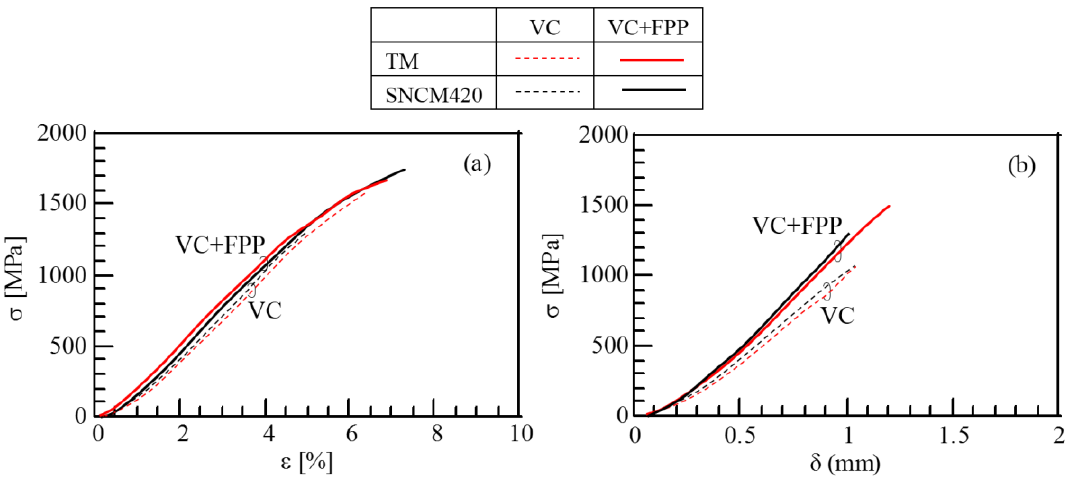
Figure 5. ( a ) Engineering stress−strain ( σ – ε ) curves of smooth specimens and ( b ) engineering stress-displacement ( σ – δ ) curves of notched specimens in TM and SNCM420 steels subjected to vacuum carburization (VC) and subsequent fine particle peening (VC + FPP). Table 3. Properties on the surface and in the surface-hardened layer and tensile properties of TM and SNCM420 steels subjected to various process.